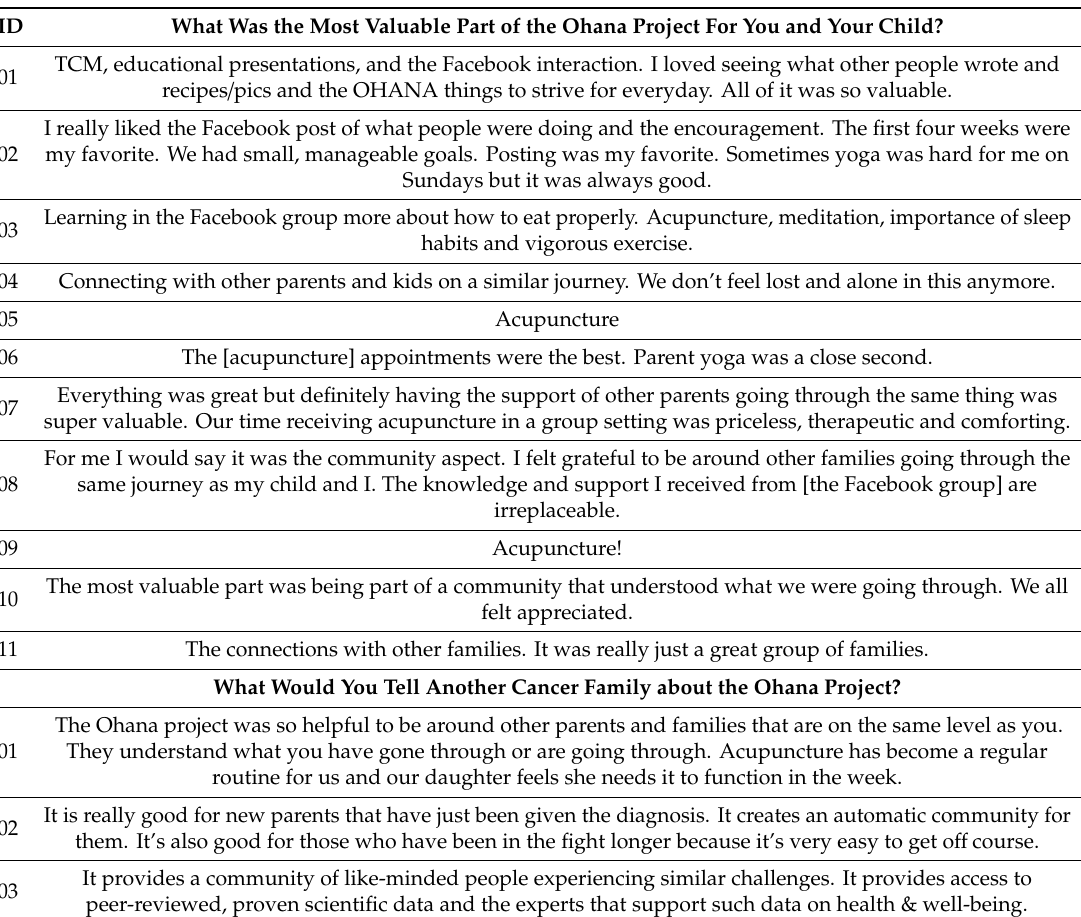
Table 2. Complete responses of parents to open-ended acceptability questions at the end of the intervention (T2). TCM: Traditional Chinese